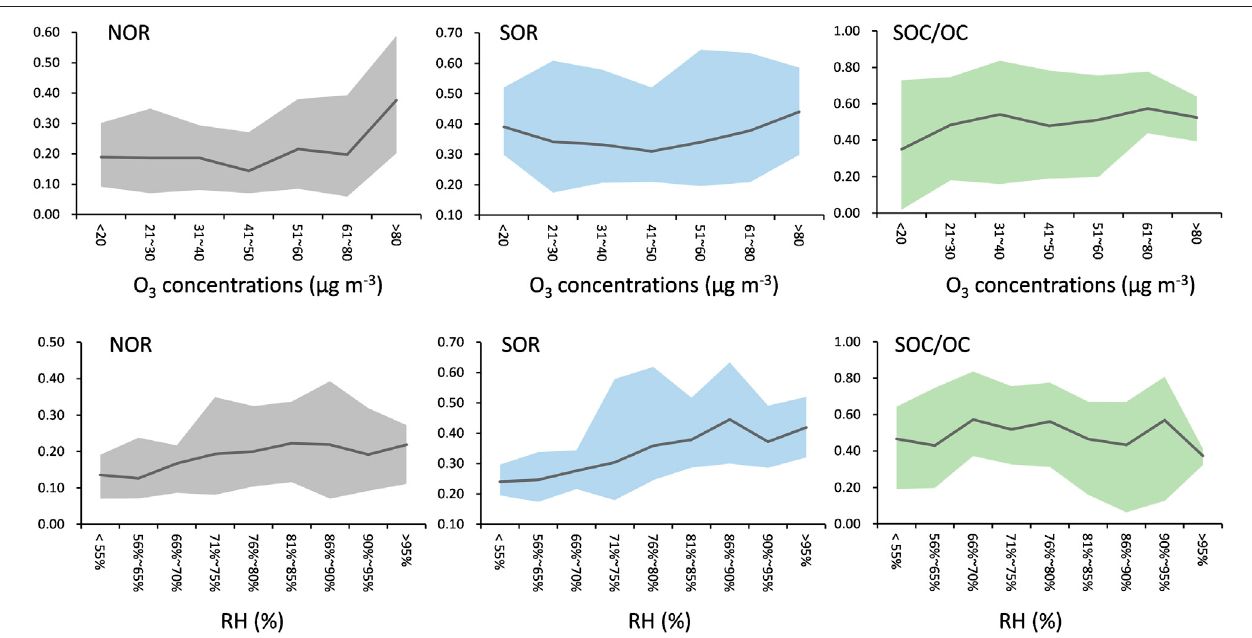
FIGURE6| Variationsofspecies(NOR,SORandSOC/OC)asfunctionsofRHandO 3 concentrations.Thesolidlinesrepresenttheaveragevalues,andtheshaded areas indicate the variation range.